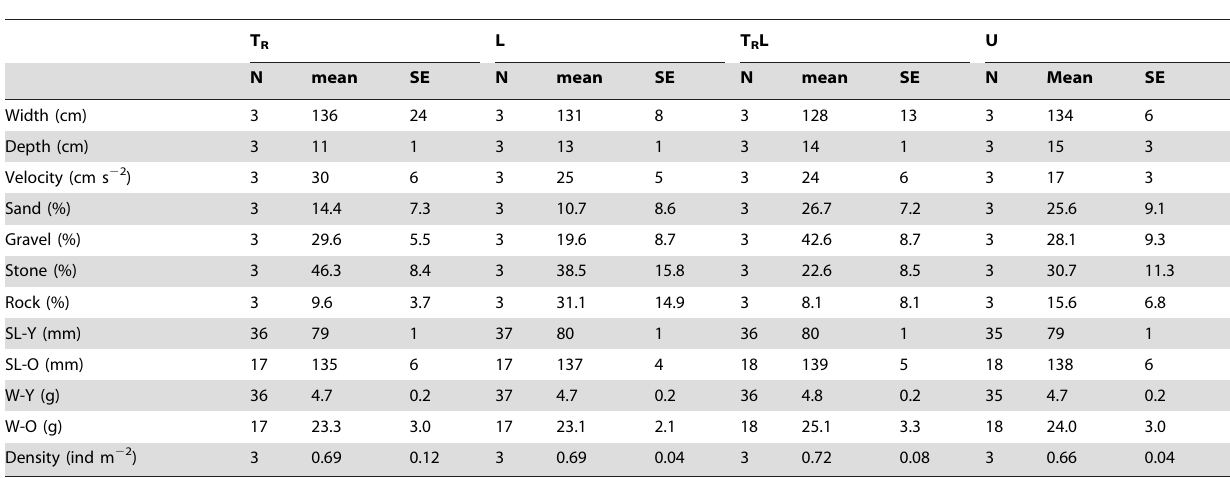
Table 1. Basic data at the start of the